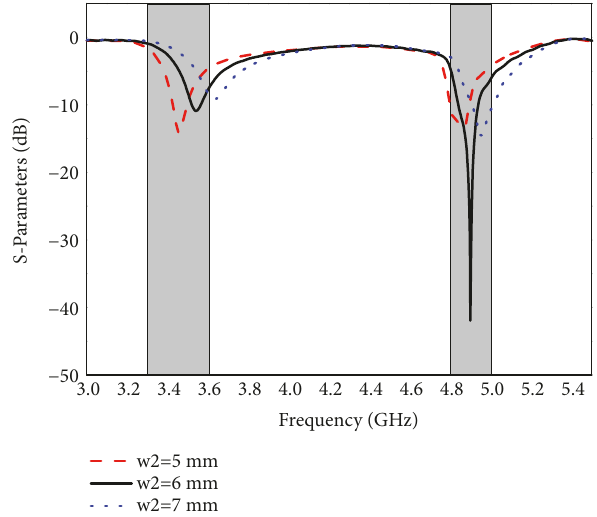
Figure 5: S-parameters of ground plane with different widths.